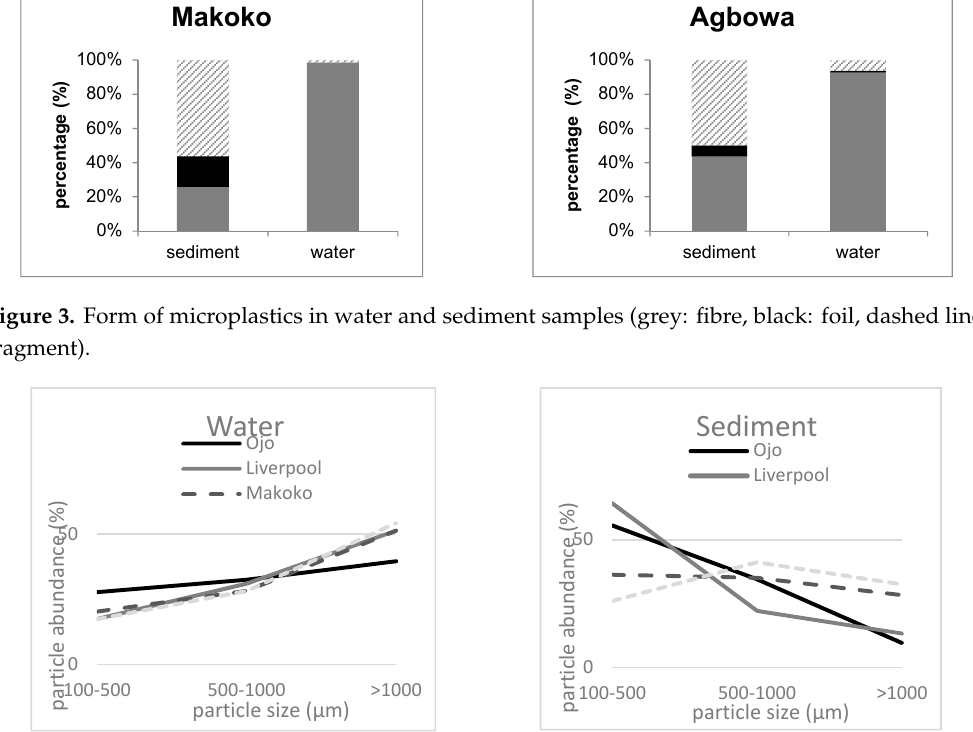
Figure 4. Size distribution of tentative MP particles (visual analysis) in the water and sediment samples of the four sampling sites.